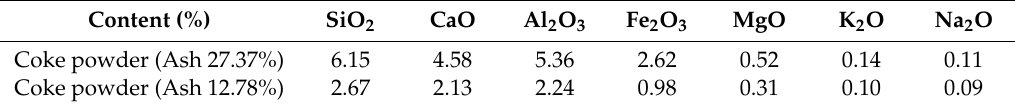
Table 2. The results from the quantitative analysis of coke powder content by XRF Content (%) SiO 2 CaO Al 2 O 3 Fe 2 O 3 MgO K 2 O Na 2 O Coke powder (Ash 27.37%) Coke powder (Ash